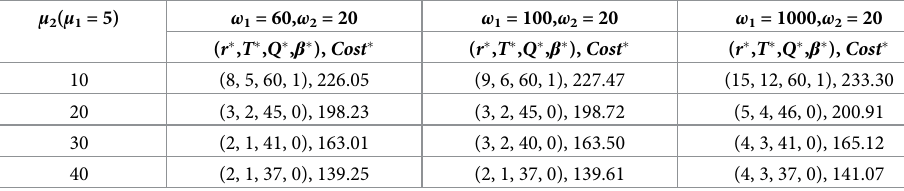
Table 4. Comparison of the relative arrival rate of order and the relative shortage cost.